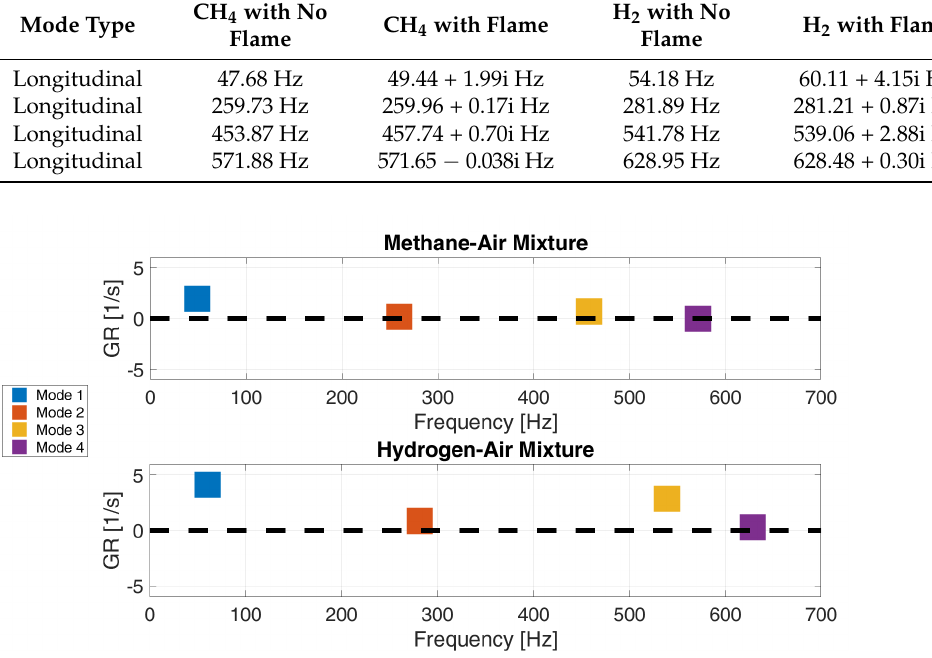
Figure 25. Comparison of the frequency and growth-rates for the two cases fueled with CH 4 –air and H 2 –air.